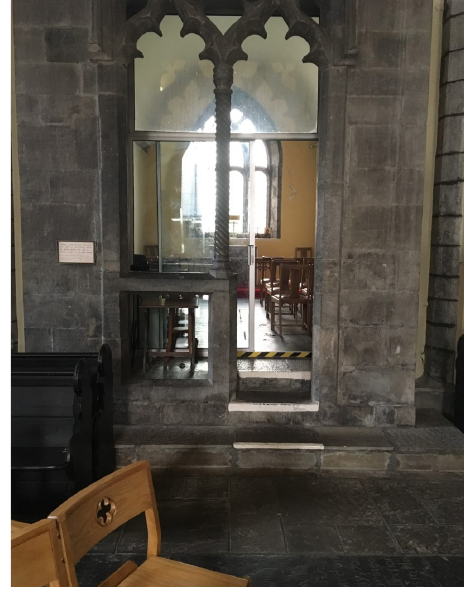
South aisle of the Collegiate church, looking towards the Chapel.